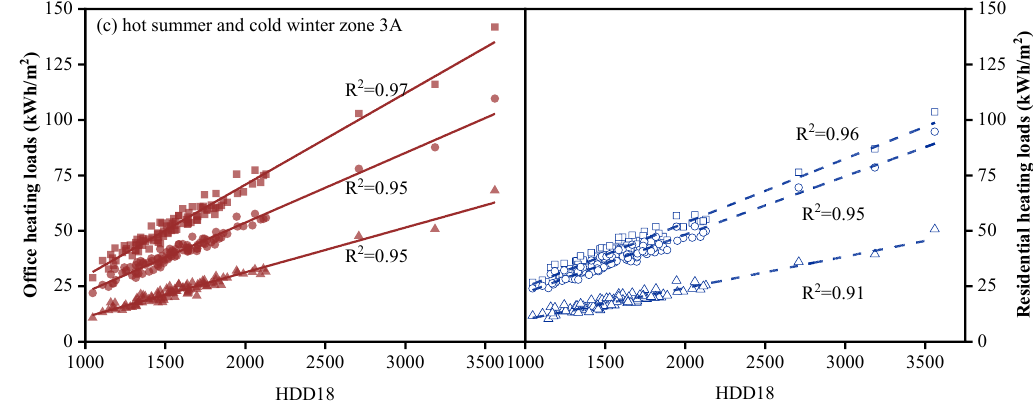
Figure 12. Annual heating loads vs. HDD18 in different climate zones: ( a ) severe cold zone 1A; ( b ) cold zone 2A; and ( c ) hot summer and cold winter zone 3A.